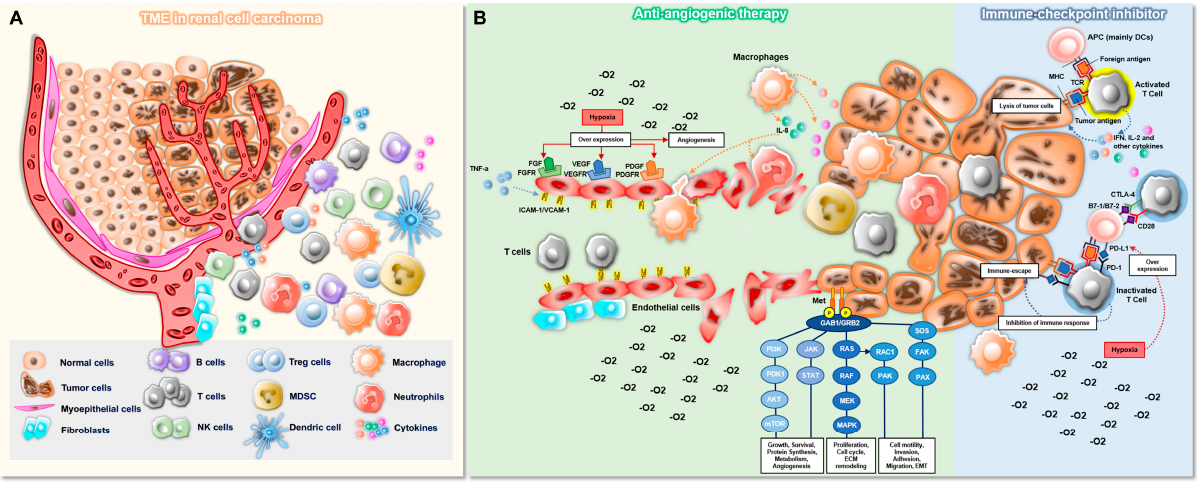
Figure 2. Interaction between angiogenesis and the immune system in renal cell carcinoma. ( A ) Components of the TME in renal cell carcinoma. ( B ) Role of TME factors in regulating angiogenesis and the immune system. The systemic targeting therapies according to their roles include anti-angiogenic agents targeting FGFR, VEGFR, PDGFR, mTOR, and Met and immune checkpoint inhibitors targeting PD-1, PD-L1, and CTLA-4, which are mainly used in clinical practice. TME, tumor microenvironment; ICAM-1, intercellular adhesion molecule 1; VCAM-1, vascular cell adhesion molecule 1; FGF and FGFR, fibroblast growth factor and fibroblast growth factor receptor; VEGF and VEGFR, vascular endothelial growth factor and vascular endothelial growth factor receptor; PDGF and PDGFR, platelet-derived growth factor and platelet-derived growth factor receptor; MDSC, myeloid-derived suppressor cell; NK cell, natural killer cell; Treg cell, regulatory T cell; APC, antigen-presenting cell; MHC, major histocompatibility complex; TCR, T cell receptor; IL, interleukin; IFN, interferon.